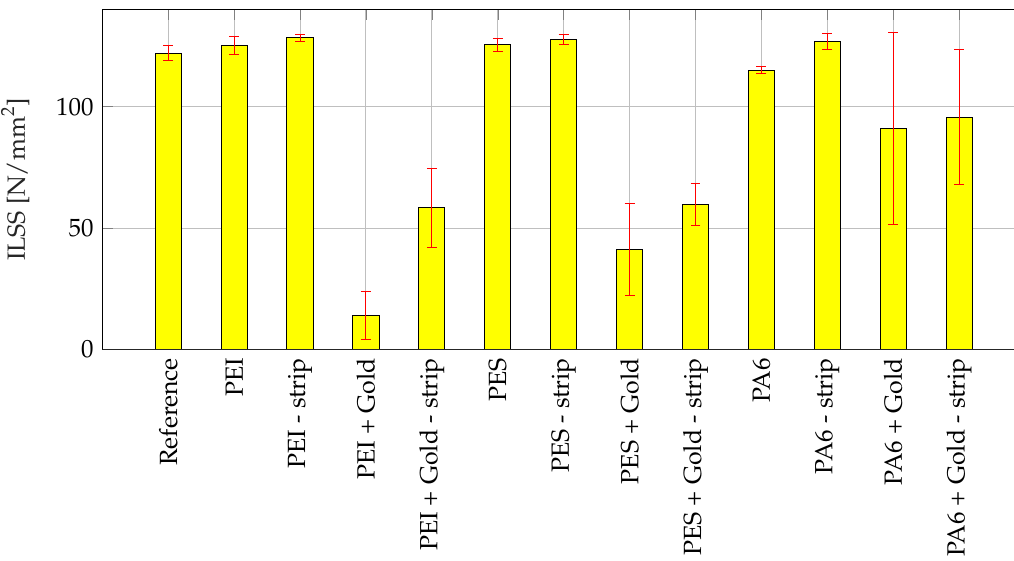
Figure 8. Influence of thermoplastic films, sensor edges and gold coating on the interlaminar shear